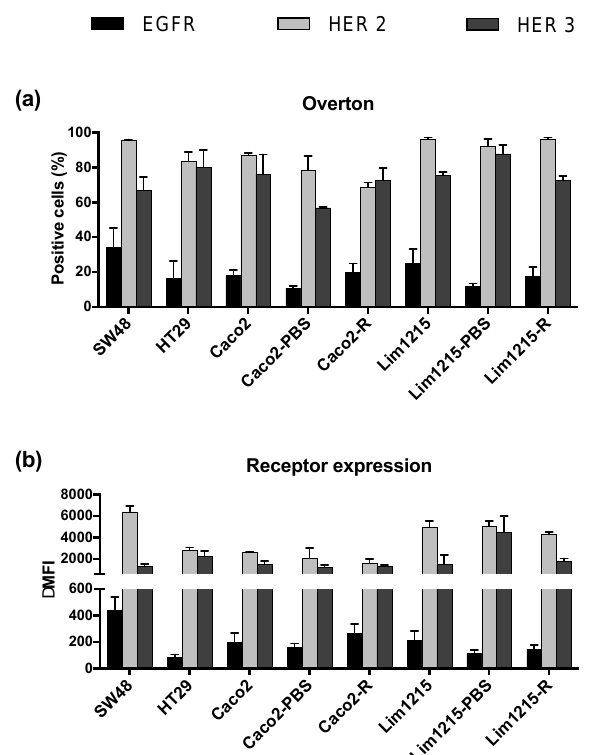
Figure 2. Human epidermal growth factor (HER) receptor expression in CRC cell lines with different sensitivities to cetuximab. ( a ) The percentage of EGFR, HER2, and HER3-positive cells (overton), determined using FACScan flow cytometer. ( b ) The expression levels of EGFR, HER2, and HER3 on the corresponding receptor-positive cells ( ∆ mean fluorescence intensities (MFI)), determined using FACScan flow cytometer. EGFR: epidermal growth factor receptor.